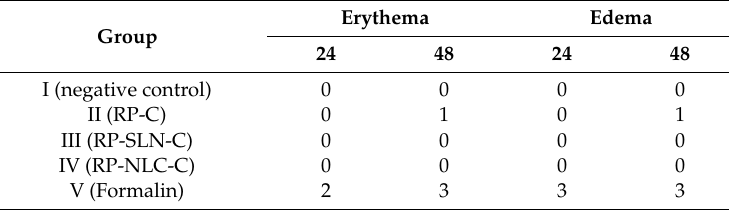
Table 9. E ff ect of RP-SLN-C, RP-NLC-C and RP-C formulations on rat skin irritation after topical administration ( n = 4).